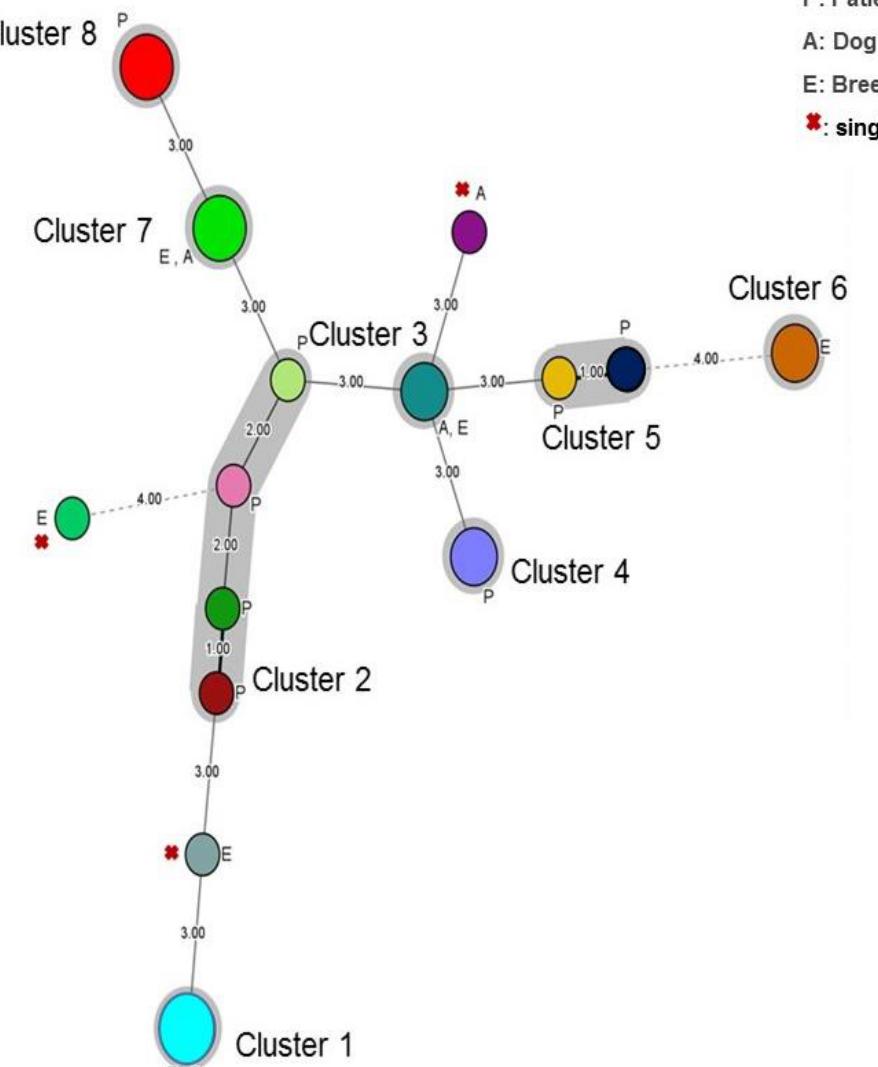
Figure 4. Minimum spanning tree showing the genotypic diversity of Malassezia restricta isolates (N = 24) based on VNTR data. Each circle shows a unique genotype and its size, the number of strains belonging to the same genotype. Connecting lines and numbers between circles show the similarity between genotypes: (1.00) indicates only one marker difference, (2.00) indicates a difference in two markers and (3.00) a difference in three markers. Table 3. Association of covariates with the ten Malassezia genetic clusters identified by minimum spanning tree (MStree) analysis.